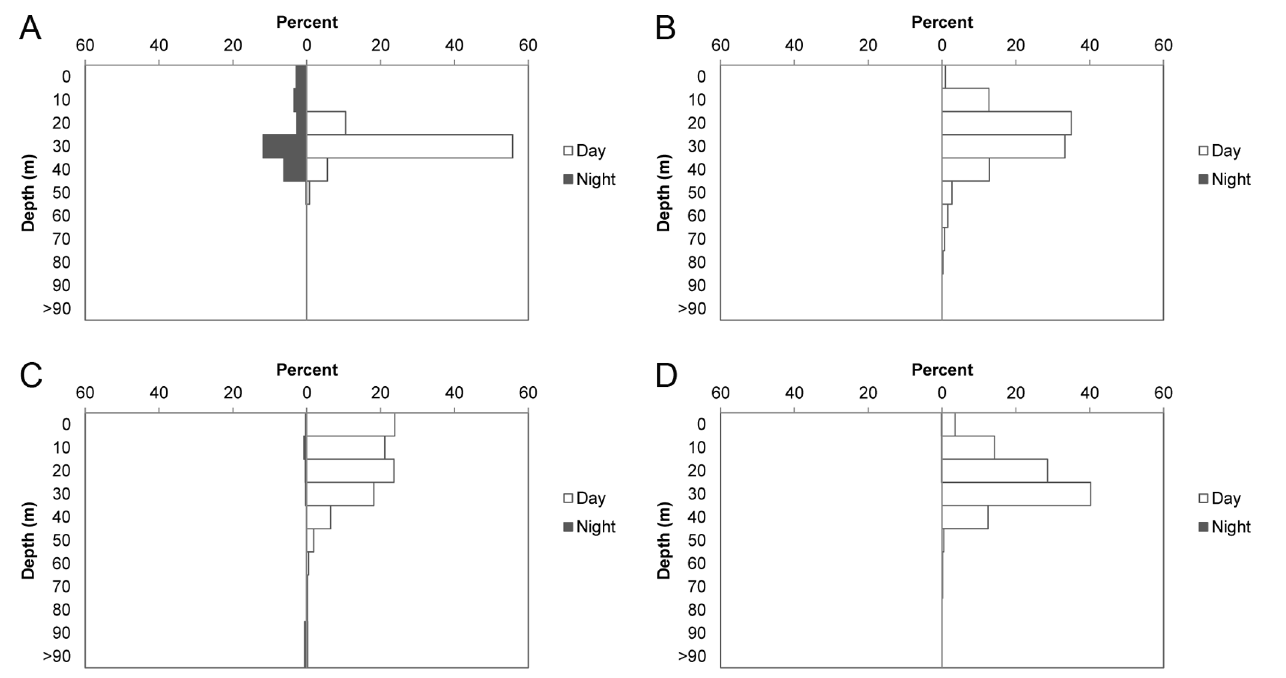
Fig. 8. Diel depth preferences for whale sharks at Darwin Island. Percentages of time expended by each shark tracked (RT-01 (A), RT-02 (B), RT-03 (C) and RT-04 (D)) at different depth ranges during day and night hours.